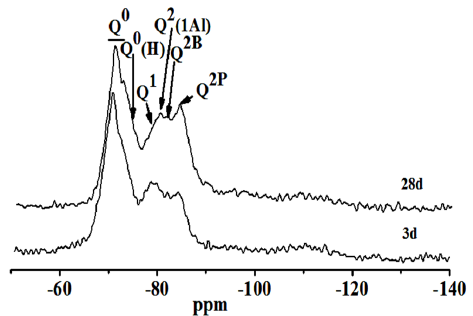
Figure 8. 29 Si NMR spectra of hydrated pastes at different ages.